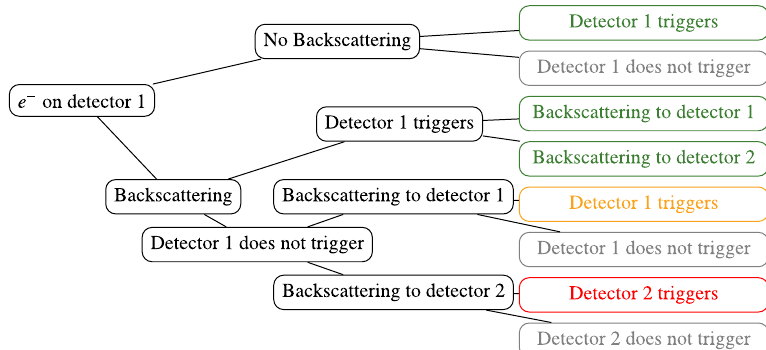
Figure 3. A first order decision tree is used to visualize the effects of backscattering. Green boxes denote events with correct emission direction and energy information. Gray boxes denote events without any trigger at all, while yellow stands for the right emission direction assignment, but detection at lower energy, and red misses both, emission direction and full energy